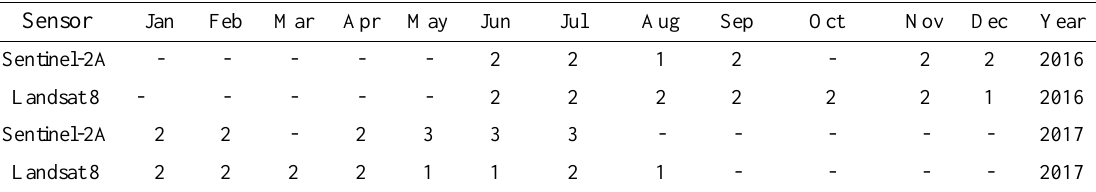
Table 1. Acquisition dates (2016 and 2017) of Sentinel-2 and Landsat 8 satellite imagery used in this